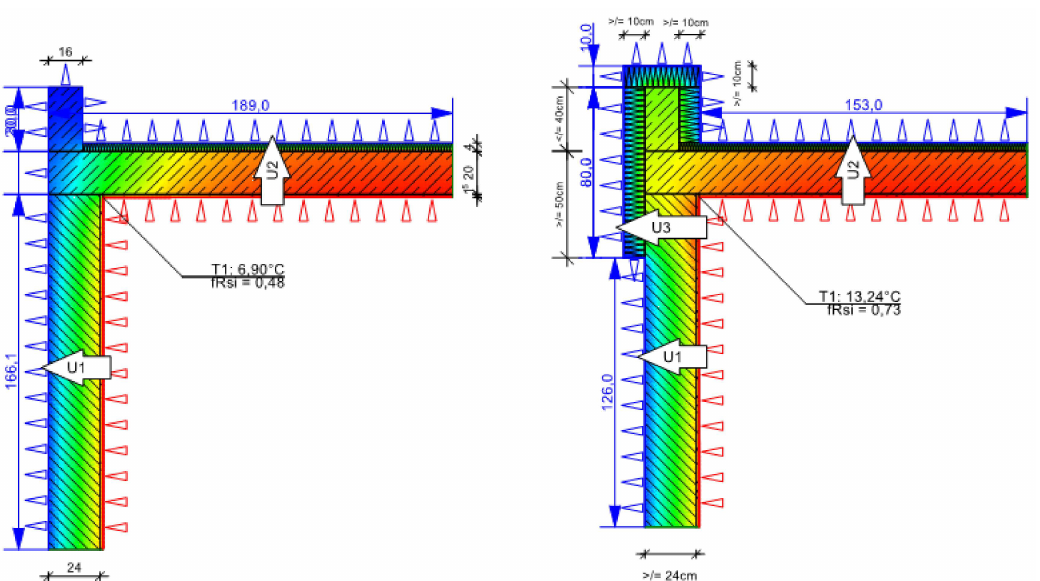
Figure A20. Before and after the thermal bridge retrofit of an attic (created with ThermCad thermal bridge simulation